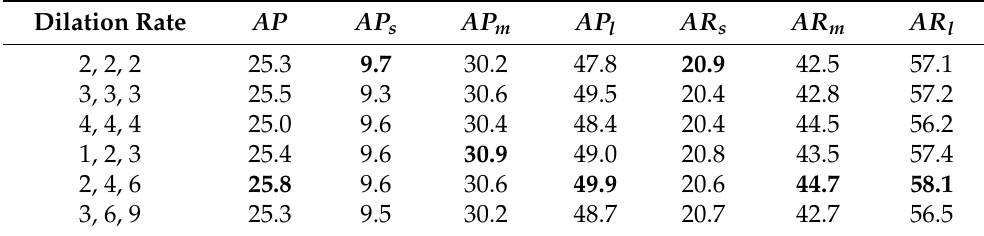
Table 7. Ablation study results for different dilation rates on BDD100K. We set two different dilation rate patterns: in one, the dilation size in each branch is identical and expands equally among the branches; in the other, a different dilation size is set for each branch, which then expands independently. According to the results, the dilation rate is set to 2, 4, and 6.